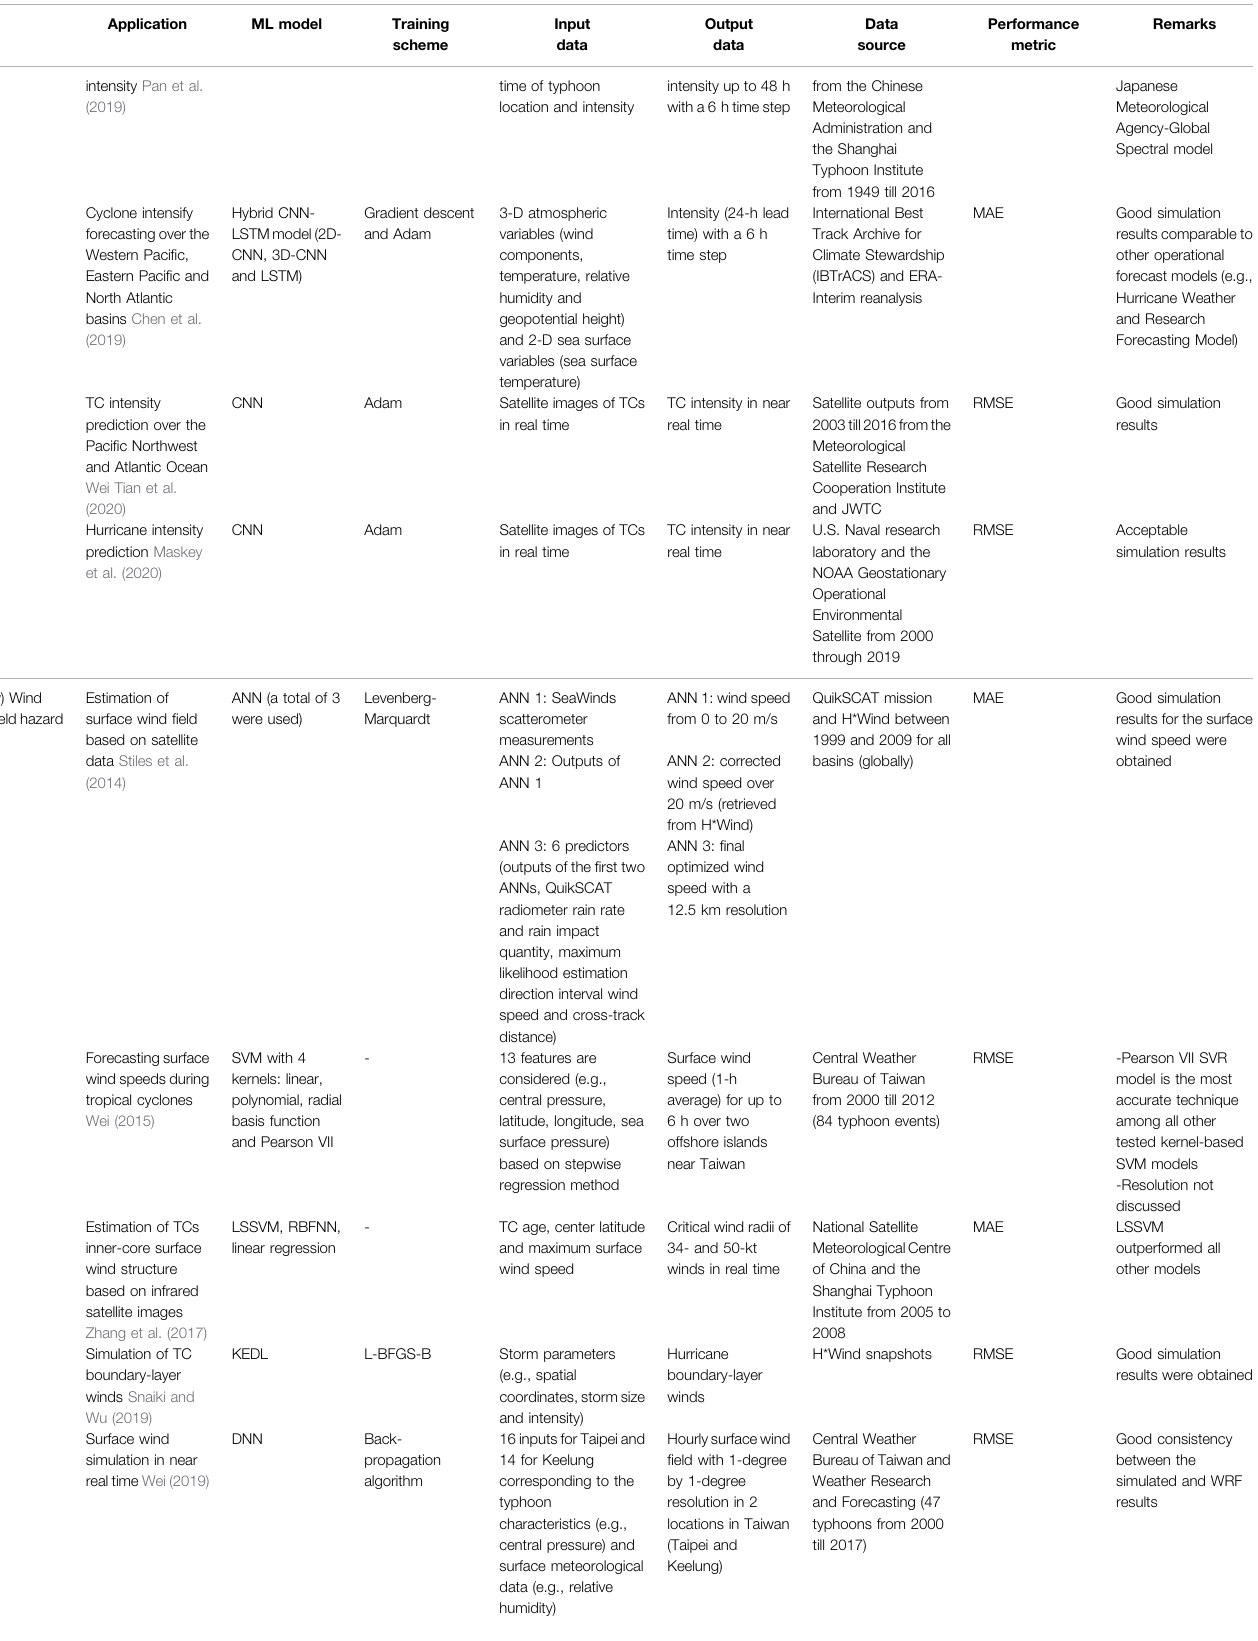
TABLE 2 | ( Continued ) Summary of ML applications for tropical